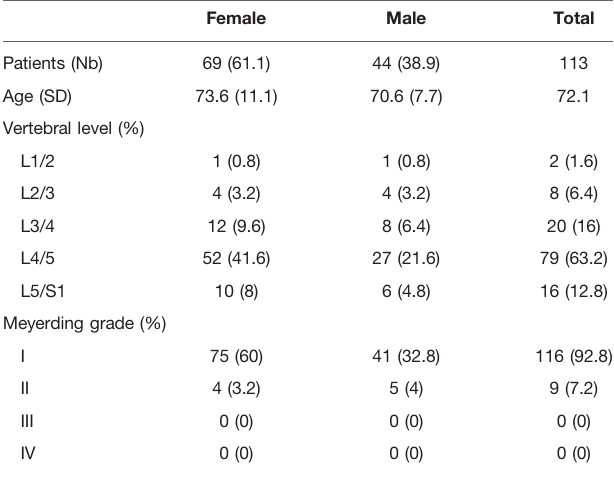
TABLE 1 | Demographic and radiographic characteristics of the patient sample.